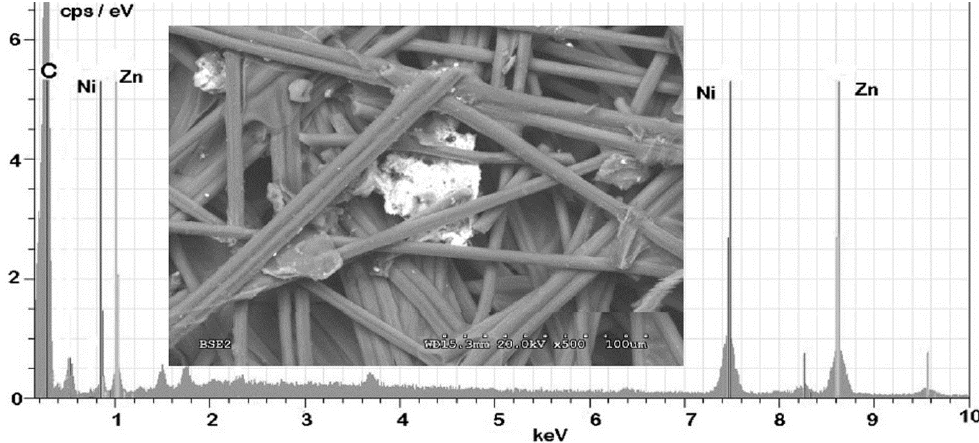
Figure 7. SEM micrograph and EDS analysis of electrodeposition at pH 5 on Toray paper carried out with a fixed working electrode potential at −1.6 V vs. Ag/AgCl during 600 s.